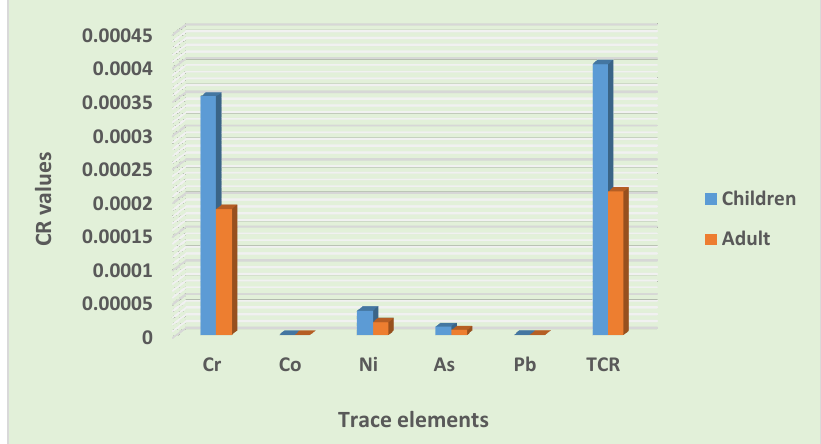
Figure 9. Contribution of trace elements to cancer risks.